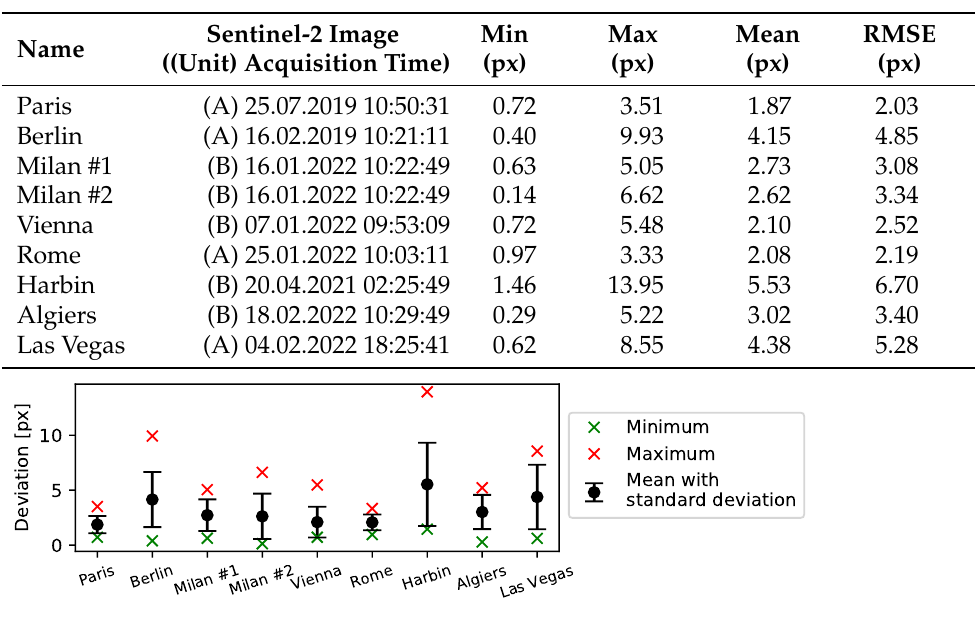
Table 3. Evaluation results of the manually selected